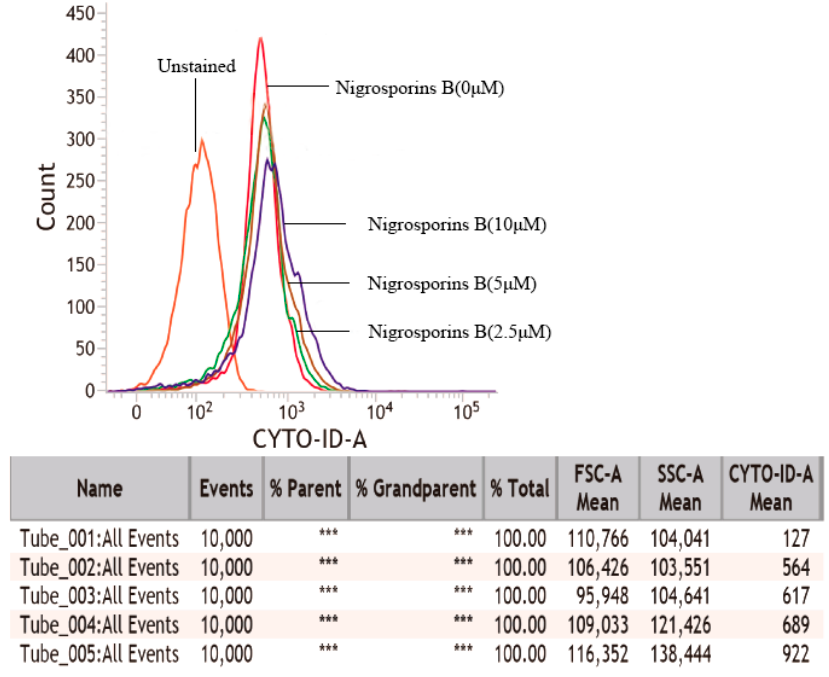
Figure 6. Cyto-ID staining to detect the relative number of autophagic vacuoles in Ca Ski cells. Cells were treated with Nigrosporins B (0, 2.5, 5, 10 µM) for 18 h. After staining with Cyto-ID Green Detection Reagent, analyzed by flow cytometry. Results are presented as histogram overlay. Tube_001 to Tube_005 in table represent the mean fluorescence intensity of unstained (background fluorescence intensity), normal cells and cells treated with Nigrosporins B (2.5, 5, 10 µM).(*** means not detected). intensity), normal cells and cells treated with Nigrosporins B (2.5, 5, 10 µ M).(*** means not